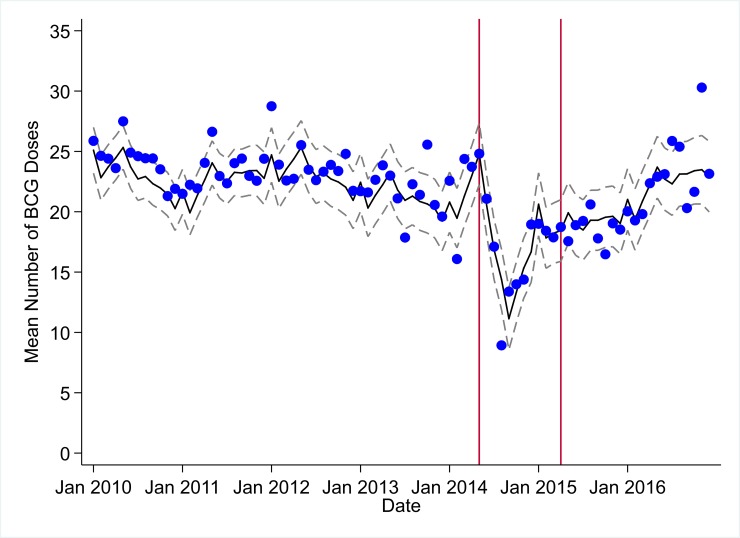
Mean trends and system losses due to Ebola virus disease (EVD) outbreak (June 2014–April 2015) for bacille Calmette–Guérin (BCG) vaccinations in a census of 379 clinics providing services in Liberia from 2010–2016, excluding Montserrado County.The black solid line represents the fitted mean from a linear mixed model using a segmented regression parameterization, random intercepts and slopes by facility, monthly indicator variables to adjust for seasonality, a fixed effect to adjust for clinic-level catchment area, and an AR(1) structure to account for autocorrelation in residual errors. Gray dashed lines are 95% confidence intervals around the fitted mean. Red lines are placed at the final month before the start (May 2014) and end (April 2015) of the EVD outbreak in Liberia.